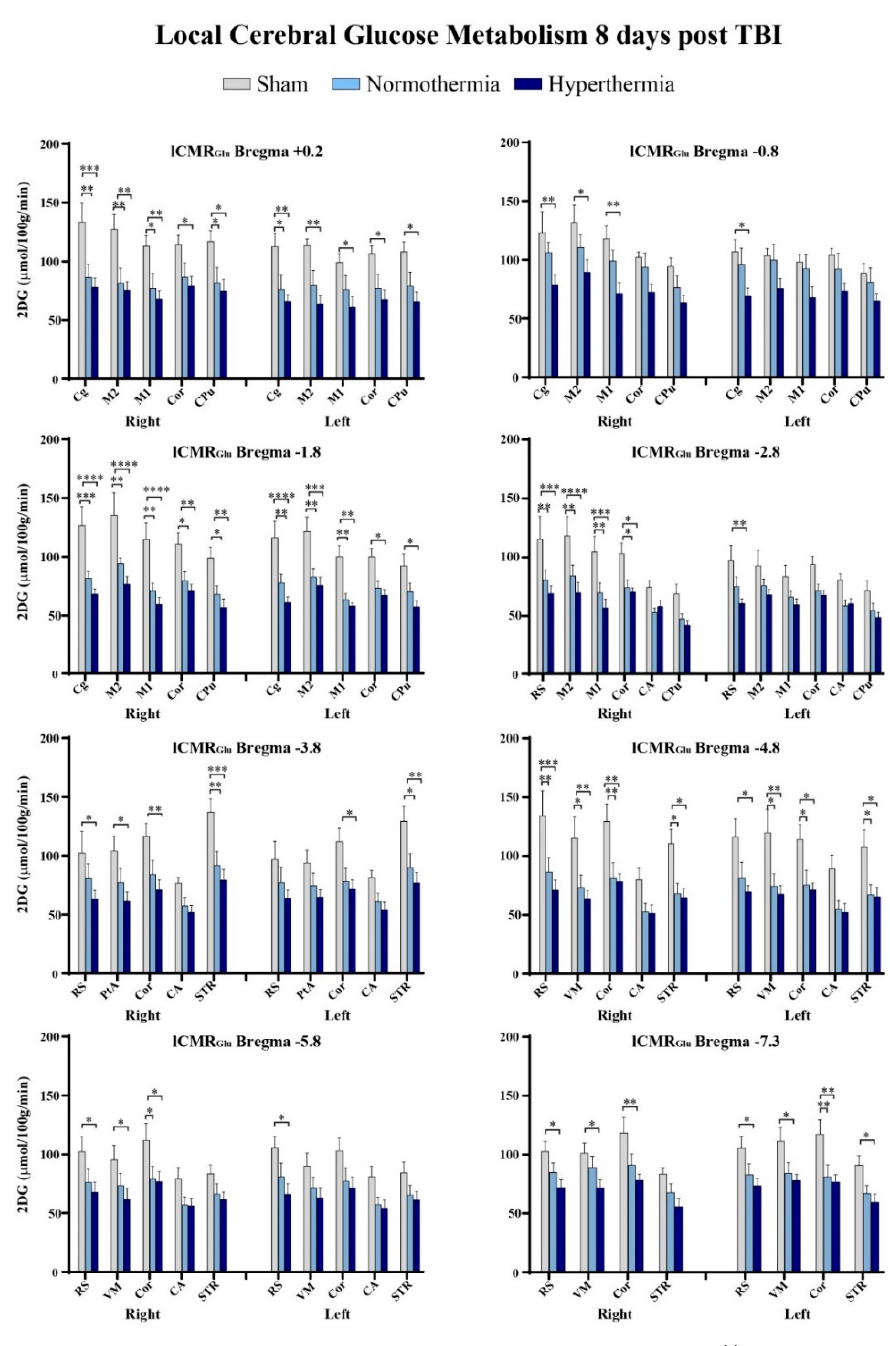
Figure 3. Eight out of nine bregma levels showed significantly decreased 14 C-2-deoxy- D -glucose (2DG) values bilaterally in normothermic and hyperthermic repetitive mTBI animals relative to uninjured sham control animals. * p < 0.05, ** p < 0.01, *** p < 0.001, and **** p < 0.0001. CA: cornu ammonis/hippocampus, Cg: cingulate cortex, Cor: cortical strip, CPu: caudate putamen, M1: primary motor cortex, M2: secondary motor cortex), PtA: parietal association cortex, RS: retrosplenial cortex, STR: striatum, and VM: visual cortex.